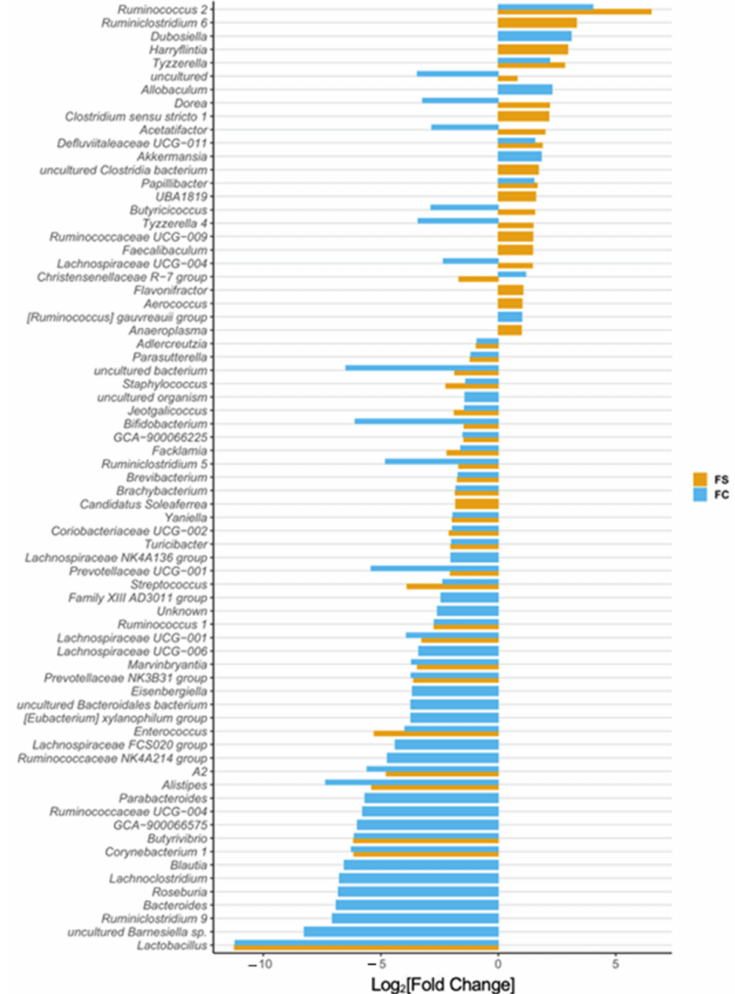
Figure 3. Differentially abundant genera due to iron form ( n = 27–29/group, 3 litters/group). Differentially abundant genera are represented as log 2 [Fold Change] from CON for each iron group. Genera are ordered by magnitude of change. Differential abundance was assessed with DESeq2, and FDR-adjusted p -values < 0.05 were considered significant. All significant results are shown in the plot, and their adjusted p -values are listed in Table S4.